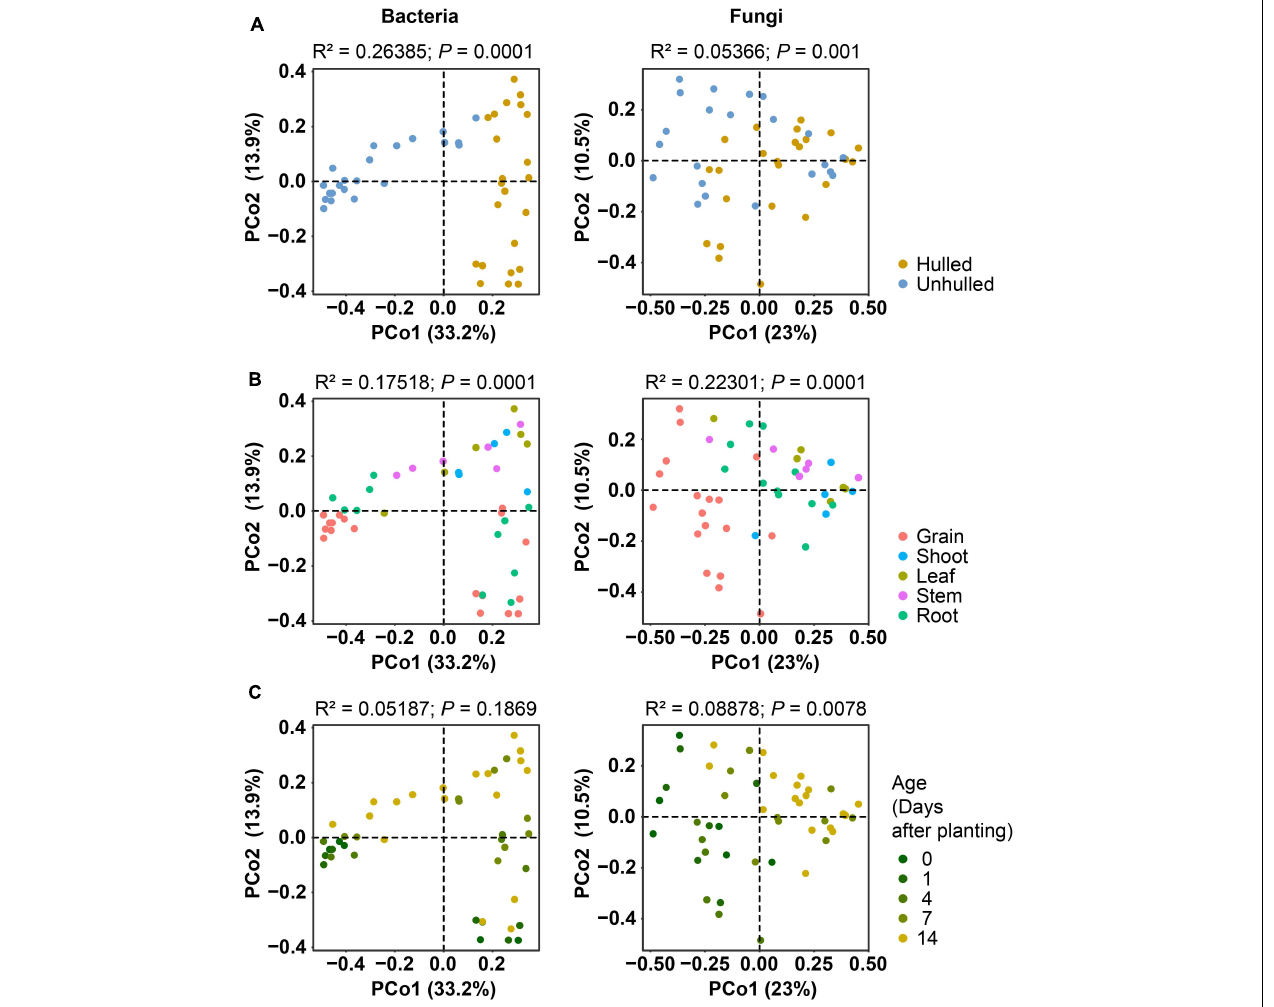
FIGURE 2 | Ordination analyses of bacterial and fungal community compositions showing the effects of seed coat presence, plant compartment, and age. (A) Contribution of seed coats to compositional variations. The presence of seed coats (“Unhulled”) is indicated with blue dots, and the absence of seed coats (“Hulled”) is indicated with yellow dots. (B) Influence of rice compartments on compositional variations. Dots are colored according to compartment. (C) Effect of age on compositional variations. More vivid yellow dots denote older rice plants. In panels (A–C) , the ordination results for bacterial communities are displayed in the left panel, and those for fungal communities are shown in the right panel. Bacterial and fungal community distances were estimated using Bray–Curtis distances with cumulative sum scaling (CSS)-normalized and log-transformed operational taxonomic unit (OTU) abundances. Results on the permutational multivariate analysis of variance (PERMANOVA) are indicated on the top of each